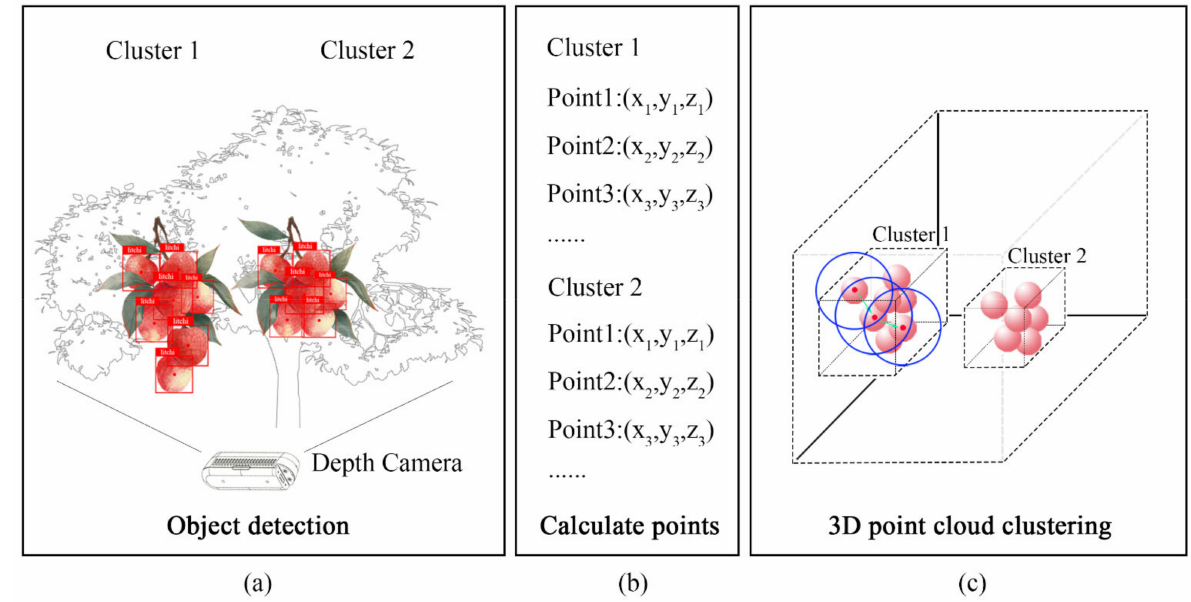
Figure 5. Long-distancelocation: ( a )objectdetection; ( b )calculated3Dpoints; ( c )3Dpointcloudclustering. YOLO is a regression method based on deep learning, which has been developed through four versions from YOLOv1 to YOLOv4 [35,36]. Through continuous innovation and improvement, it has attained top performance. Here, the recent YOLOv5 network was chosen for the detection of litchi individuals by considering the aspects discussed below; the network architecture is shown in Figure